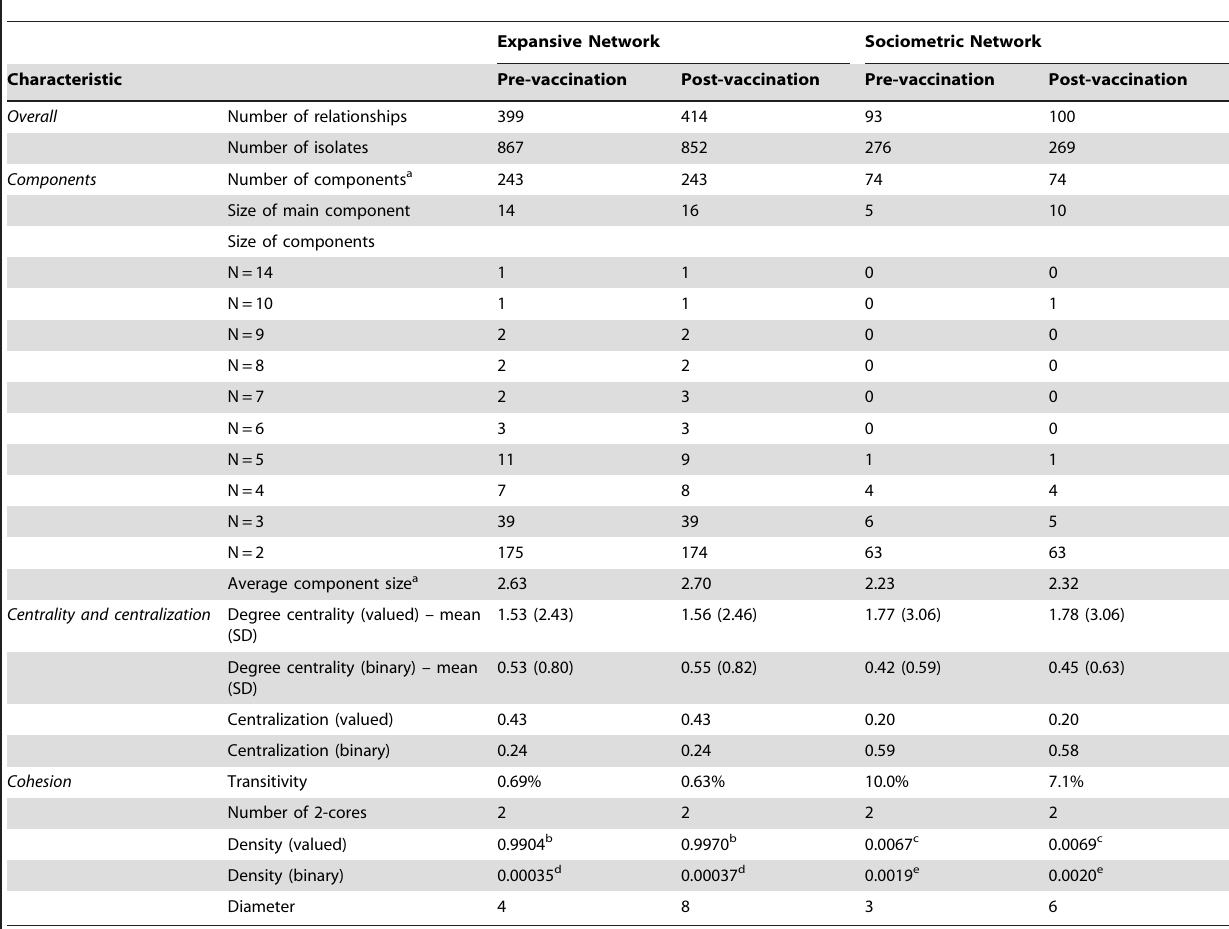
Table 2. Comparison of pre- and post-vaccination risk